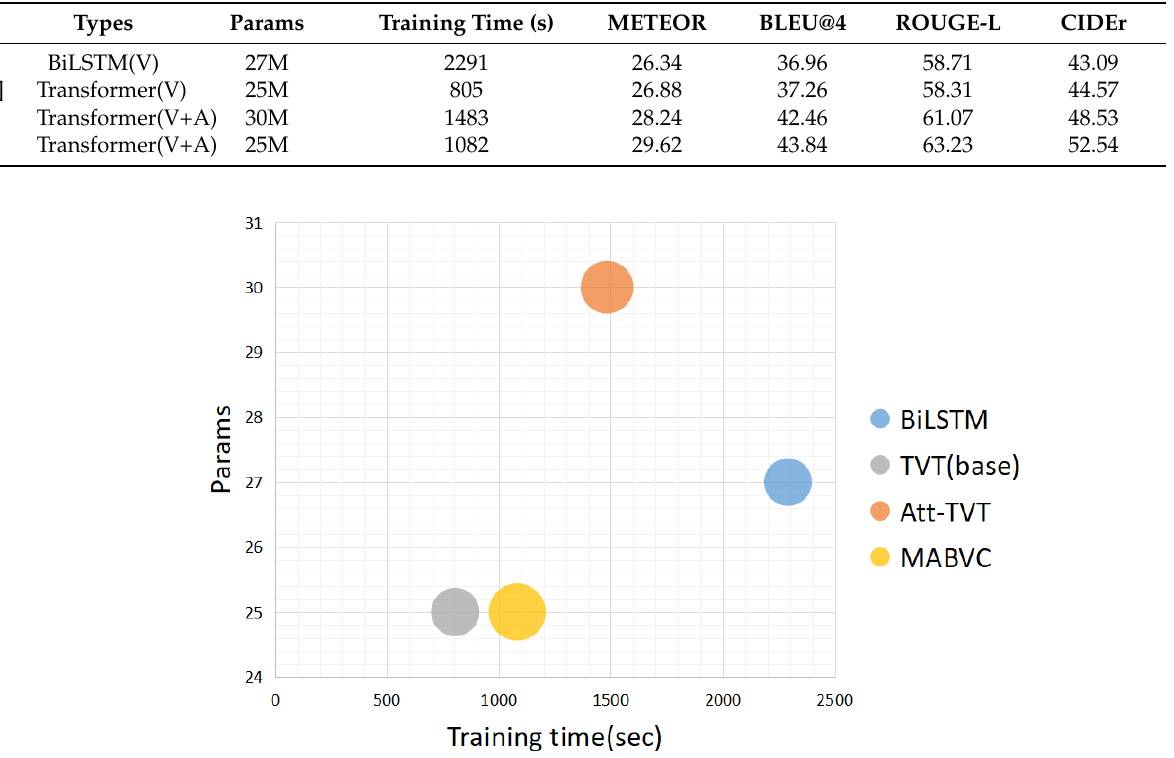
Figure 3. Comparison of parameters. Training time and CIDEr values of different methods in MSR-VTT